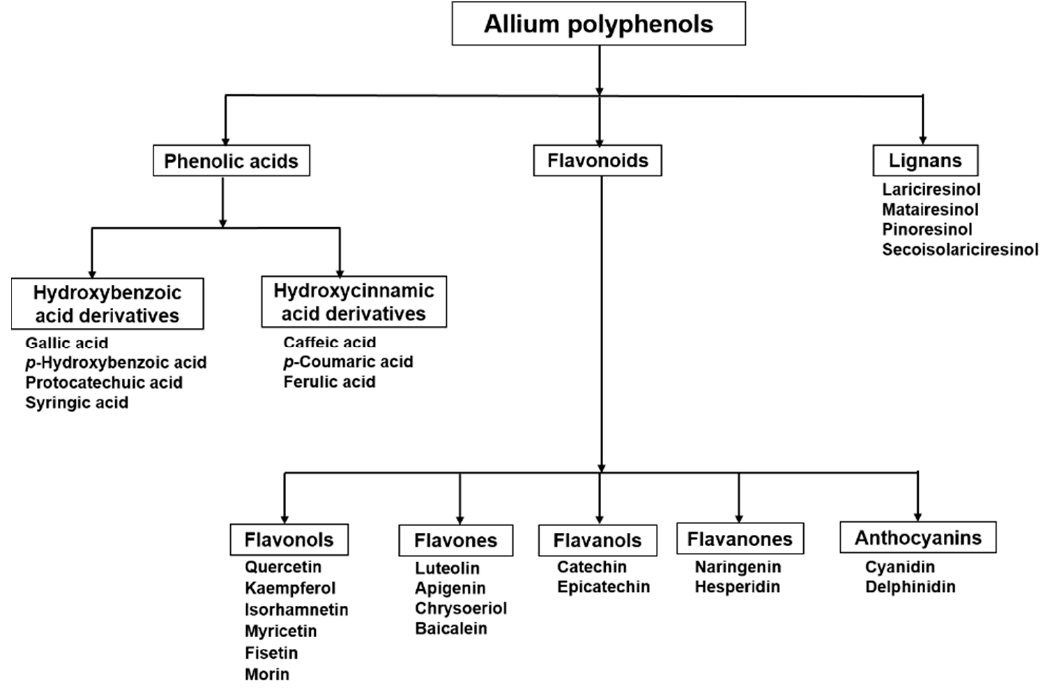
Figure 1. Polyphenolic compounds in the genus Allium .